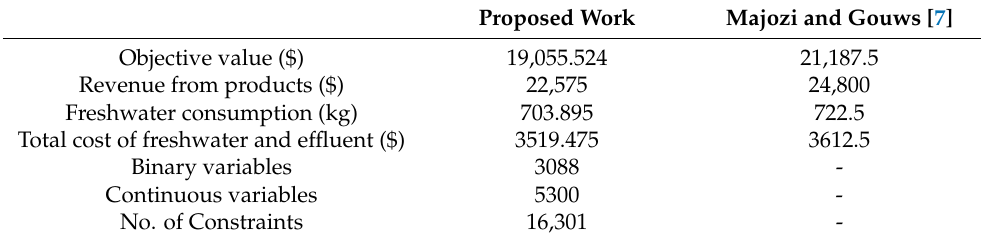
Table 3. Comparison of results for case study 2 with the literature.